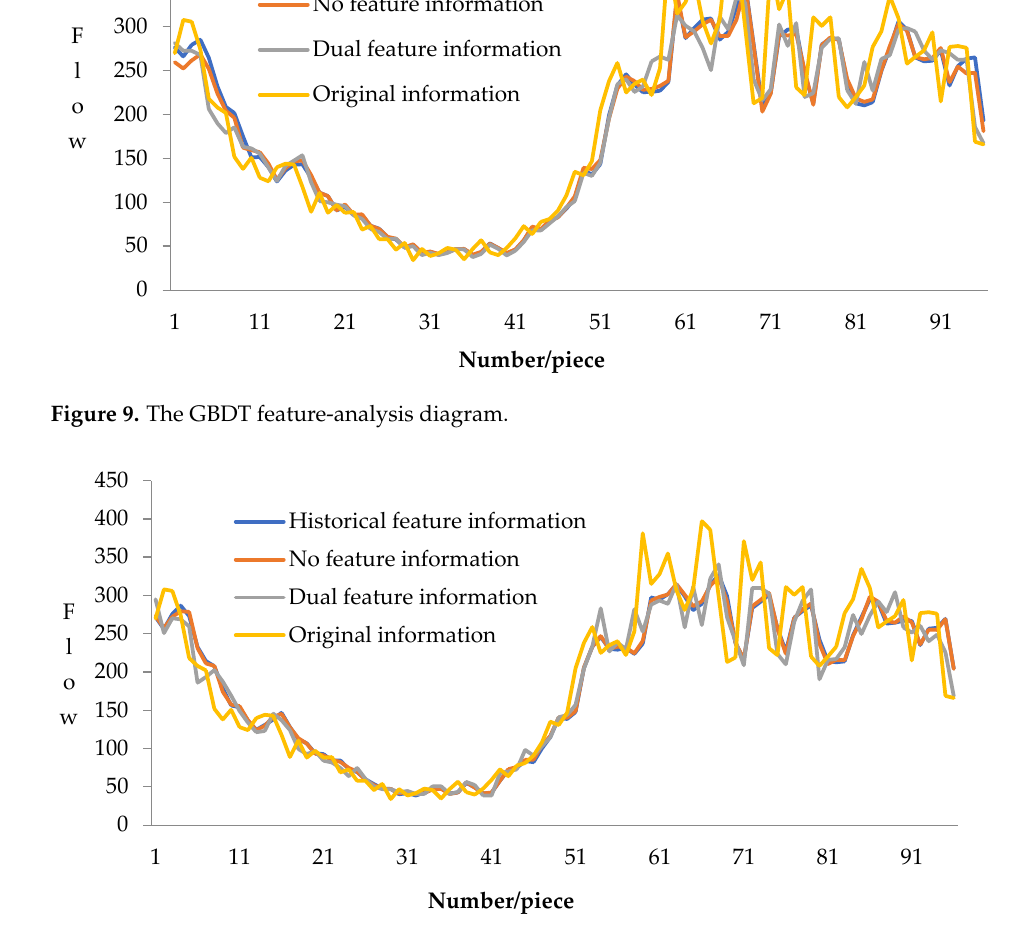
Figure 11. The GRU feature-analysis diagram.